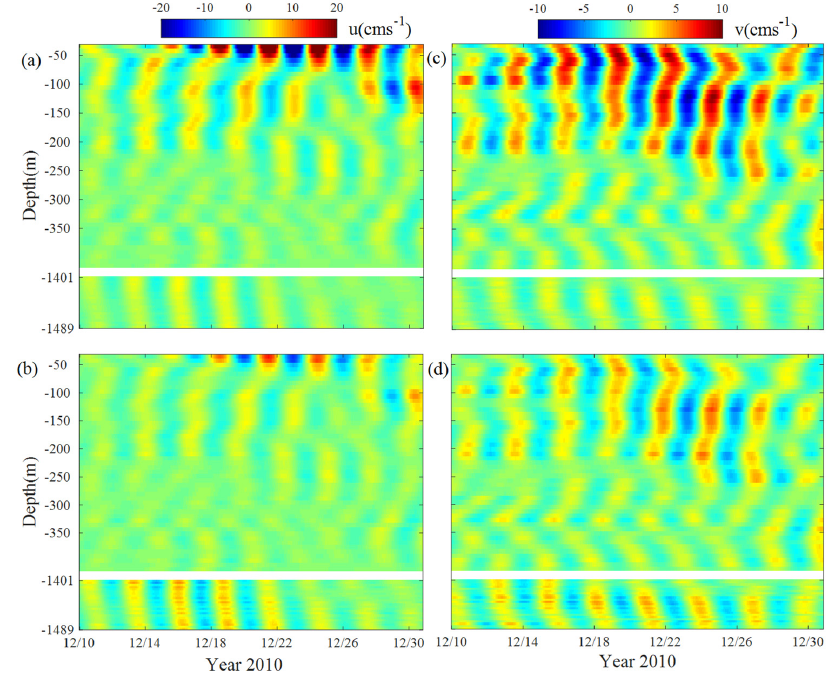
Figure 7. Depth-time maps of raw near-inertial velocities ( a , c ) and WKB-scaled velocities ( b , d ) in eastward ( a , b ) and northward ( c , d ) directions in December 2010. Through 2D Fourier filtering, the eastward velocities are further decomposed into downward and upward energy-propagating components. Figures 8 and 9 show the depth-time maps of the upward phase (downward energy) and downward phase (up- ward energy) propagating eastward near-inertial velocity components.